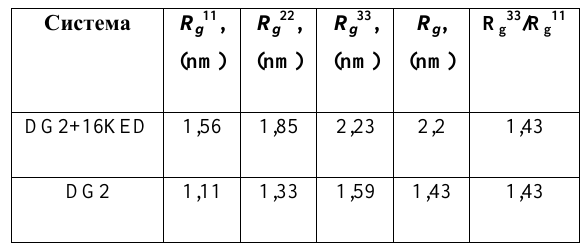
Table 1.Size Rg, main components of inertia tensor Rg 11 ,